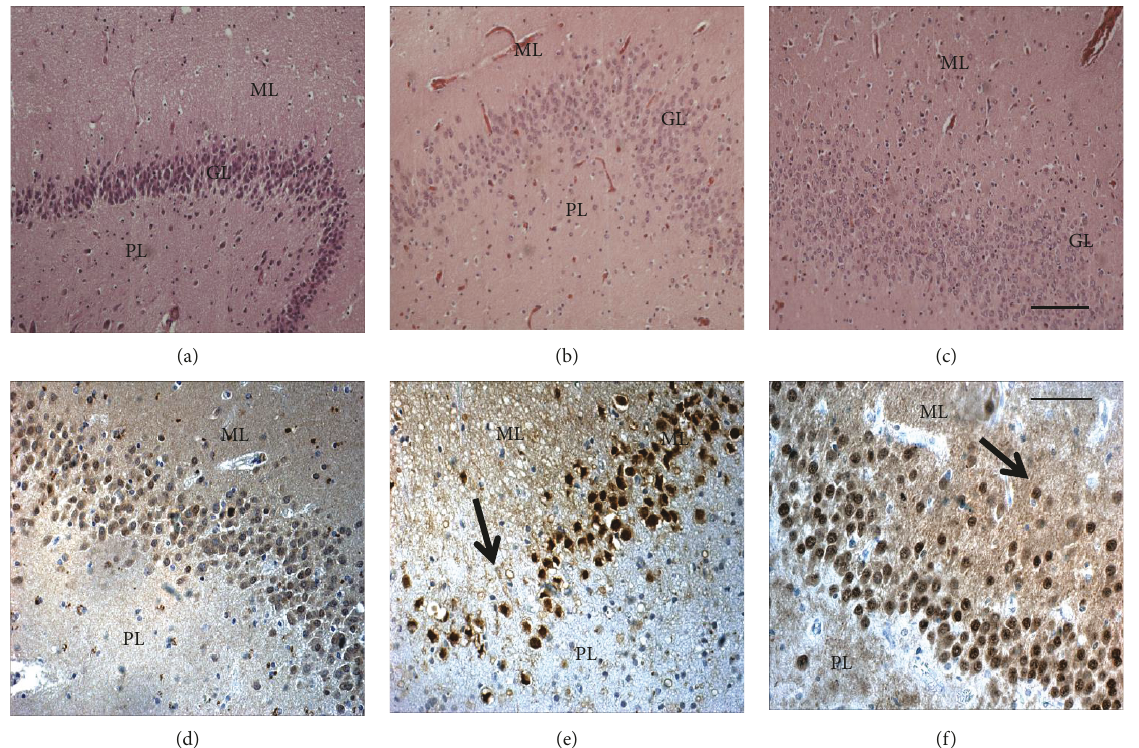
Figure 1: Hippocampal dentate gyrus from controls and patients with TLE and hippocampal